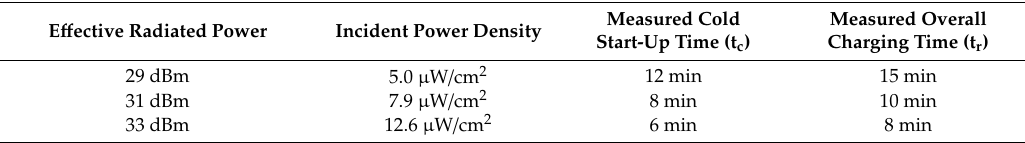
Table 1. Cold start-up time and second charging time as a function of the incident power density for the 7-mF